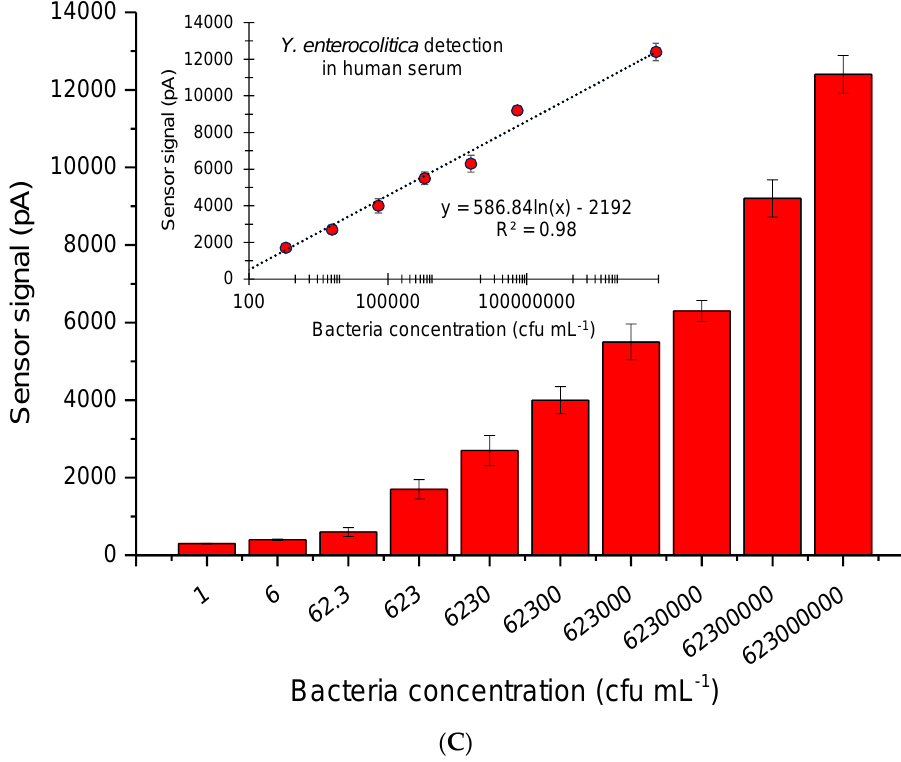
Figure 7. ( A ) The real-time measurement curves obtained for di ff erent concentrations of Y. enterocolitica in milk, using 5000 ppm GQDs as enzyme mimics. ( B ) The quantification of Y. enterocolitica in milk; inset: Regression analysis resulting in R 2 value 0.98 ( n = 6). ( C ) Overall results of Y. enterocolitica detection in human serum; inset: Regression analysis resulting in R 2 value of 0.98 ( n = 6). The bacterium was measured in a concentration range of 1 - 6.23 × 10 8 cfu mL − 1 for both assays. Table 1. Comparison of various techniques for the detection of Y. enterecolitica